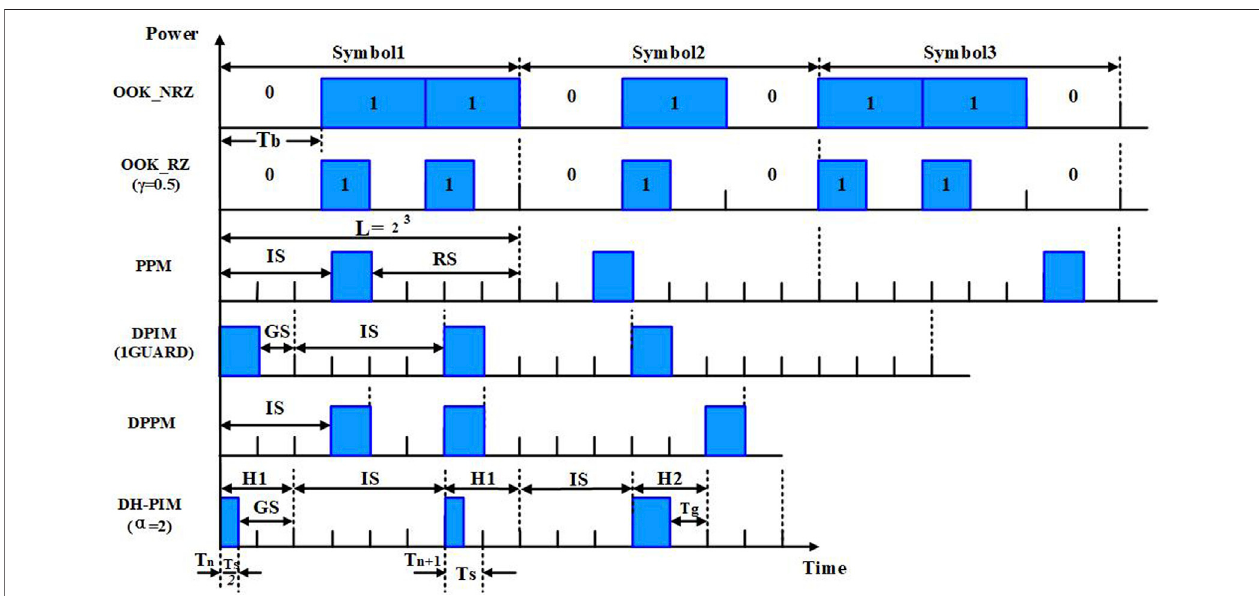
FIGURE2 | Time waveforms forOOK, DPIM, PPM, DPIM, DPPM, DH_PIM ( α (cid:1) 2). NRZ non – return-to-zero, RZ return-to-zero, IS information slots, RSredundant slots,GSguardslots;thetime-domainwaveformre fl ectsthebitmappingrelationshipsfortheseveralintensitymodulations.Thepresenceorabsenceofanopticalpulse isusedtorepresent1bitofdatainOOKmodulation,andthedurationtimeoftheopticalpulseisequalto1-bitduration,whereasthedurationoftheopticalpulseofOOK- RZ modulation is less than the duration ofasingle bit. When the dutyratiois0.5, the light pulse duration ofOOK-RZ modulation ishalfof thesingle bit duration. For PPM, The slot position of the optical pulse, corresponding to the decimal value of the M-bit input data, represents the information bit. DPIM and DPIM remove the redundant time slot after the optical pulse compared with PPM, whereas DH-PIM not only removes the redundant time slot after the PPM optical pulse but also reduces the number of time slots within a single symbol compared with DPIM.